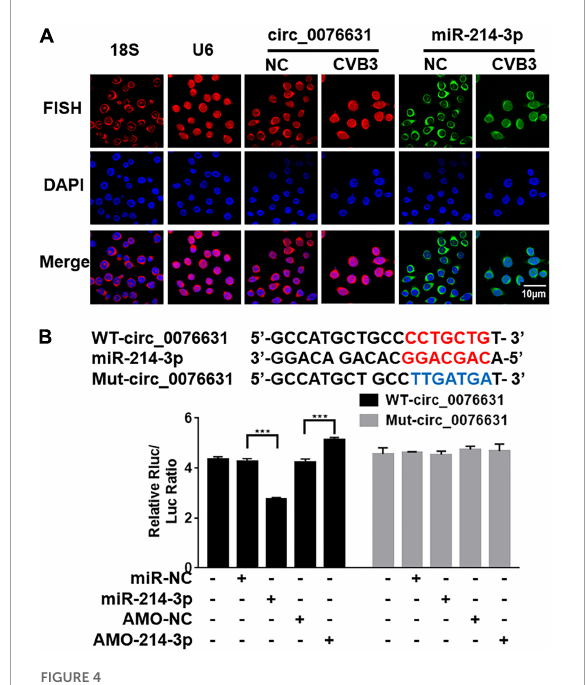
FIGURE4 Verification of miR-214-3p binding to circ_0076631. (A) FISH assay was performed to observe the cellular localization of circ_0076631 in HeLa cells with CVB3 infection. Circ_0076631, 18S rRNA, U6 are showed in red. Nuclei are stained with DAPI (blue). (B) The miR-214-3p-binding sequence in wild-type circ_0076631 and the mutated circ_0076631. Plasmids expressing Renilla luciferase (Rluc) fused with wide-type circ_0076631 (containing miR-214-3p-targeting site, WT-circ_0076631) or with mutated circ_0076631 (without miR-214-3p-targeting site, Mut-circ_0076631) sequence were co-transfected with miR-214-3p mimic (miR-214-3p), miR-NC, AMO-miR-214-3p (AMO-214-3p), or AMO-miR-NC (AMO-NC) into HEK293T cells, respectively. Luciferase activity was